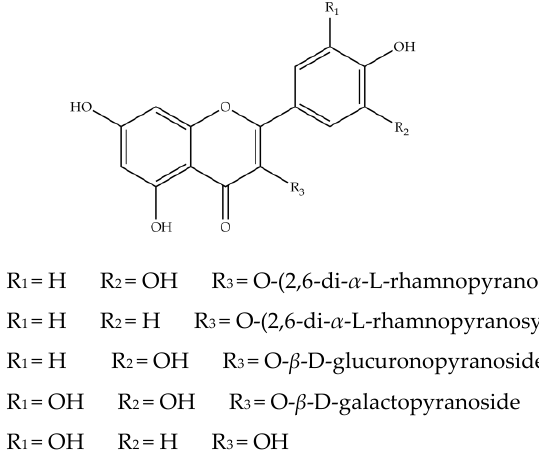
Figure 3. The structures of Compounds 1 – 5 and 8.